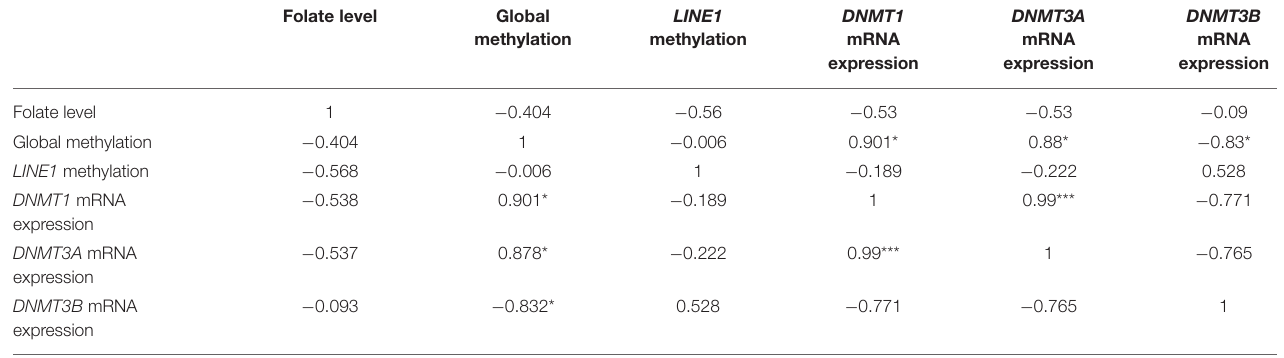
TABLE 1 | Correlation analysis of mRNA expression of various DNMTs, folate level, and global methylation level among placental groups (normal first, second and third trimester, and preeclampsia).